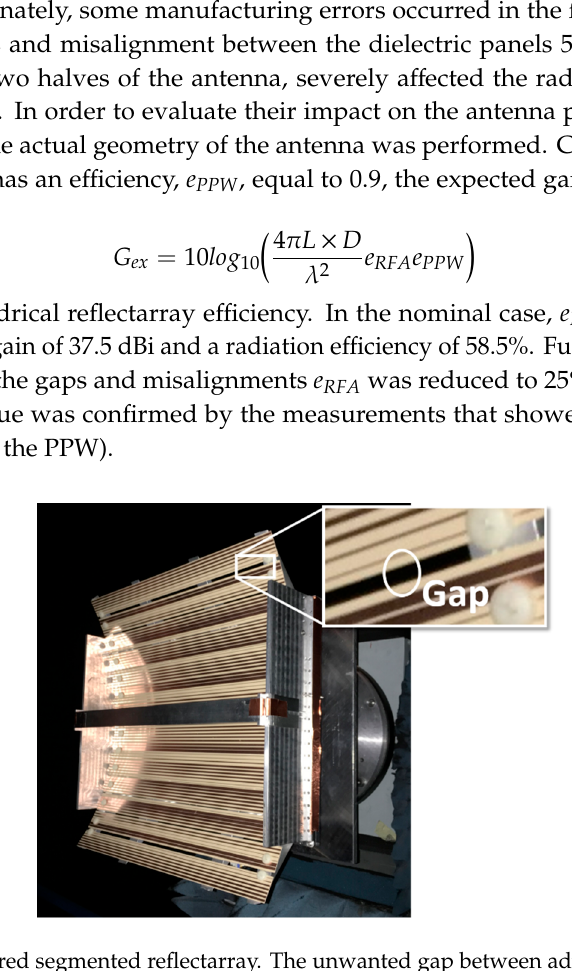
Figure 4. Comparison of field distribution (magnitude and phase) along the aperture of the parabolic cylindrical reflector and of the cylindrical reflectarray.